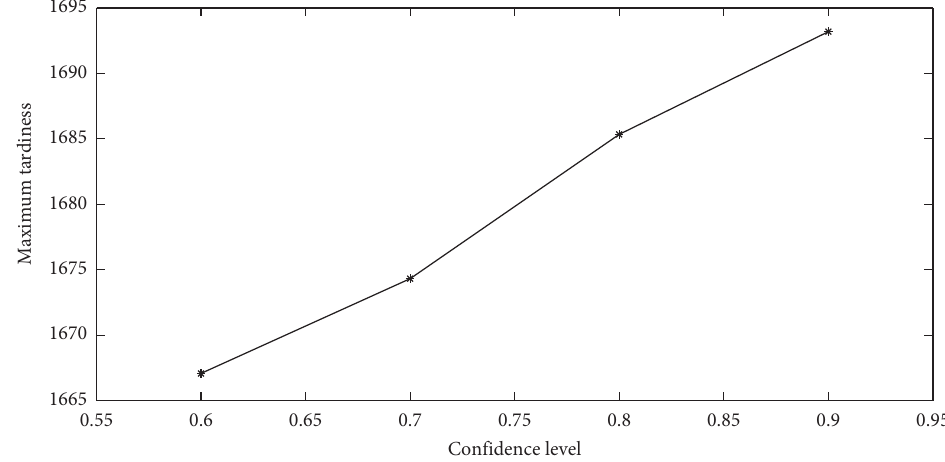
Figure 4: The sensitivity of solution for maximum lateness